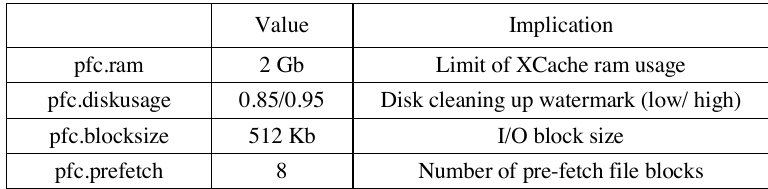
Table 1. Configurations of the test XCache server.